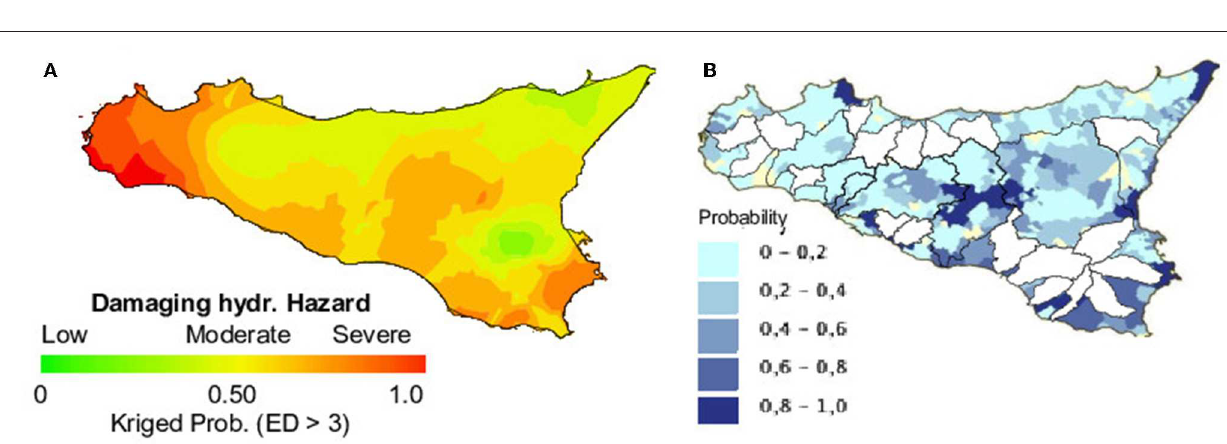
FIGURE 8 | Comparison of (A) kriged probability for erosivity density (ED > 3 MJ ha − 1 h − 1 ) for October with (B) damaging hydrological risk maps (joint probability of landslides and floods occurrence) with 5-years return period ( Guzzetti et al., 2002) for the Sicily